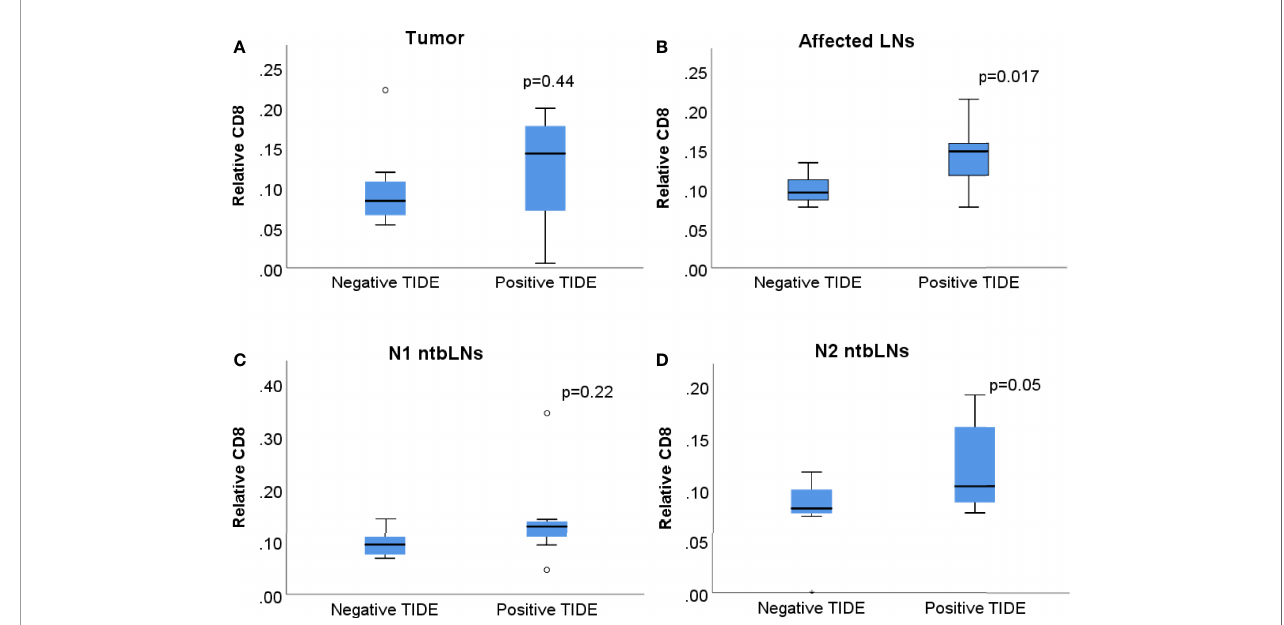
FIGURE 2 | Boxplots of relative abundance of CD8+ cells in patients with negative and positive TIDE scores in (A) tumor tissue, (B) tbLNs, (C) N1 ntbLNs and (D) N2 ntbLNs. Boxes show interquartile range, whiskers show lowest and highest quartile.